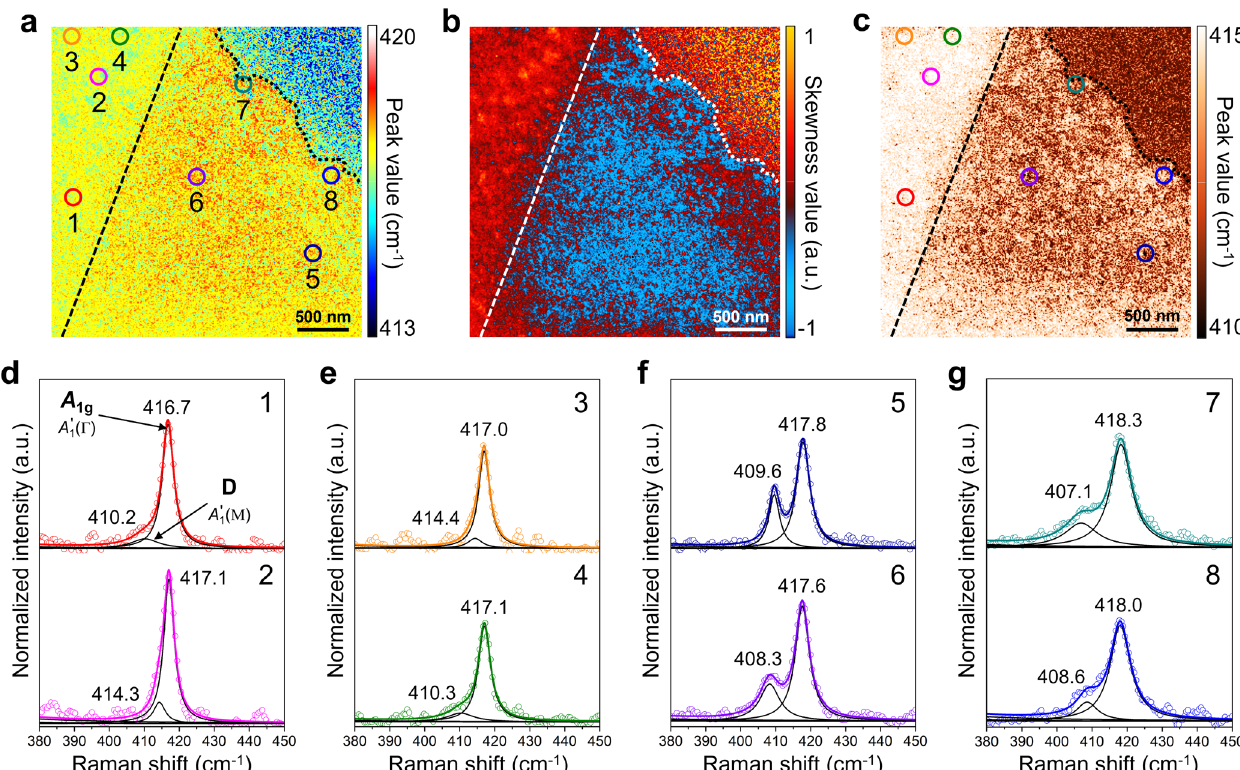
Fig. 3 TERS imaging of monolayer WS 2 . a Peak distribution image for A 1g mode derived from Fig. 2. b A 1g peak skewness image. c Peak distribution image of D mode. TERS spectra were extracted from the d middle and e edge regions of the α -domain, and the f middle and g edge regions of the β -domain. Each colored (numbered) circle in the TERS images corresponds to the spectra of the same color (number). These spectra d – g were fi tted using Lorentzian